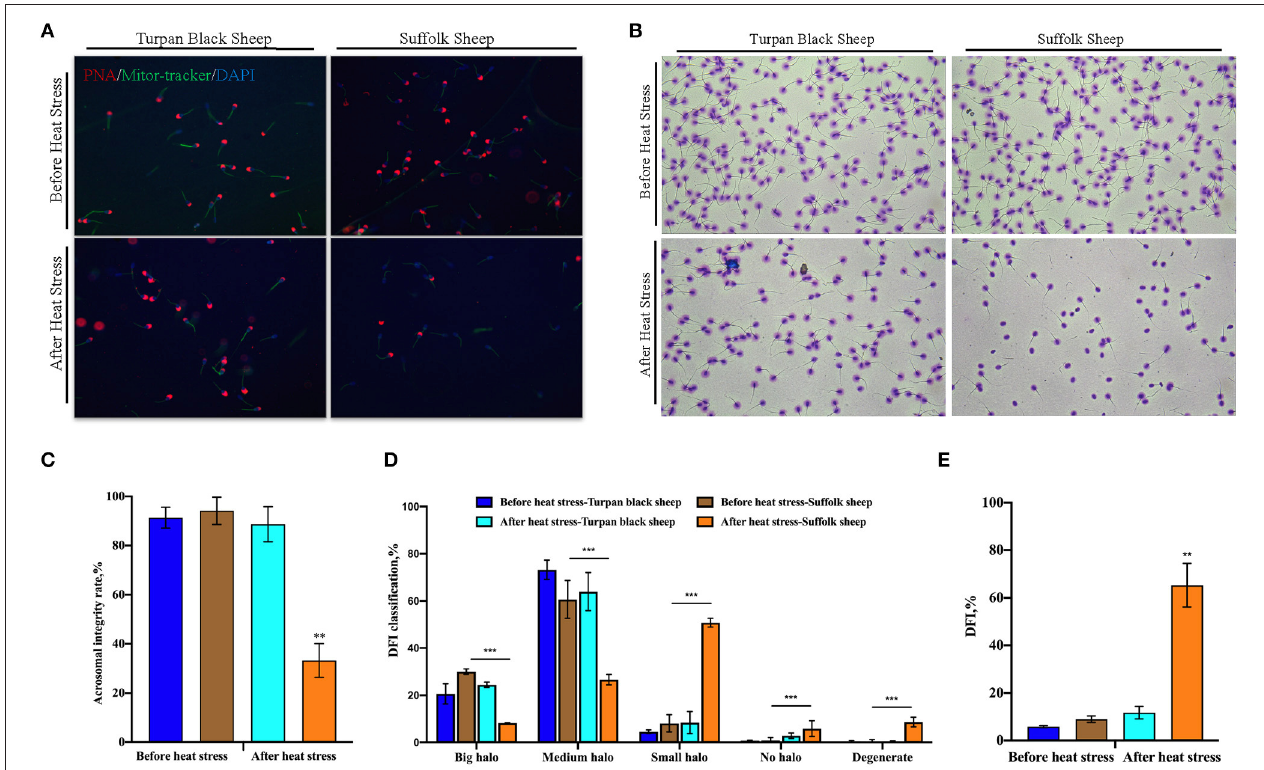
FIGURE 3 | Changes of sperm acrosome morphology and DNA damage after HS (A) 200 × confocal laser microscopy: PNA (red fluorescence) labeled sperm acrosome; Mitor Tracker labeled mitochondria; DAPI (blue fluorescence) marks the nucleus. (B) SCD sperm DFI images. (C) Sperm acrosome morphological statistics. (D) SCD results showed the percentage of large halo, medium halo, small halo, non-halo and degenerate sperm. (E) DFI statistics. Significance was calculated by T -test, ** means p < 0.01, *** means p <